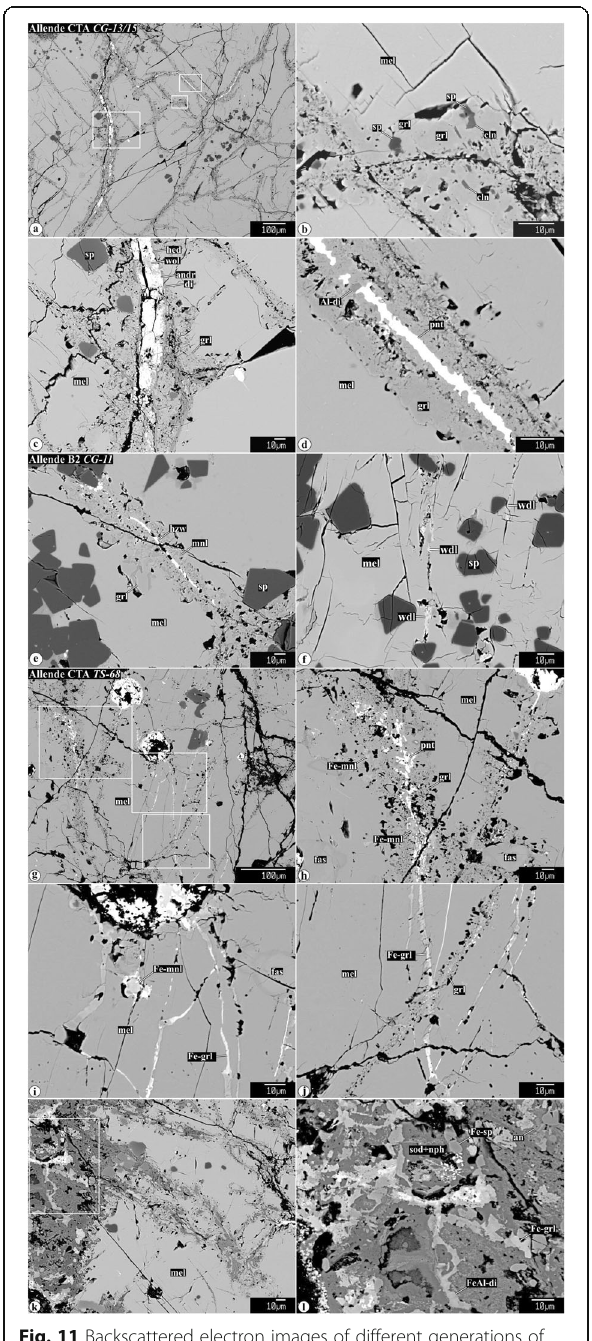
Fig. 11 Backscattered electron images of different generations of veins in the Allende coarse-grained CAIs. Regions outlined in a and g are shown in detail in b − d and h − j , respectively. Central regions of some grossular-rich veins are occupied by pentlandite, heazlewoodite, or andradite + wollastonite + hedenbergite. g − l Occasionally, grossular-rich veins are crosscut by veins composed of ferroan grossular and